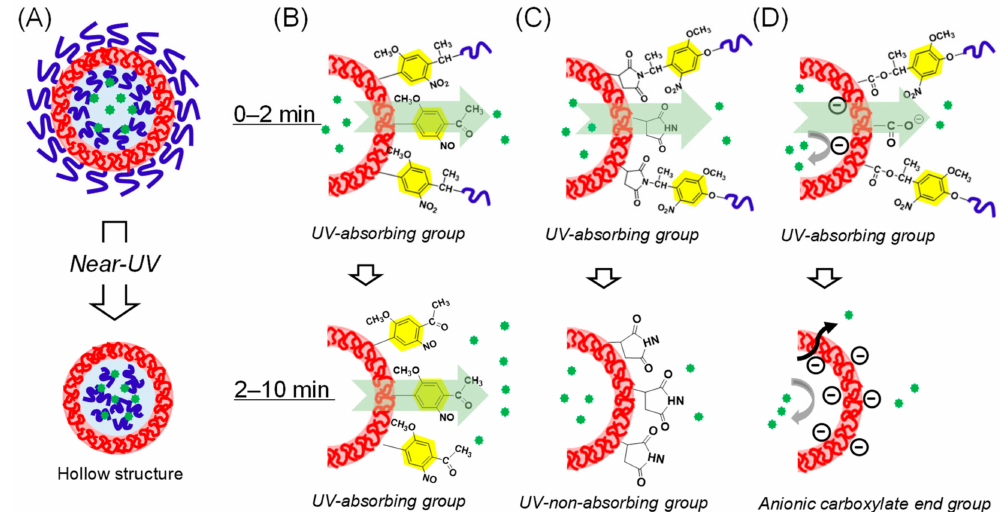
Figure 8. Summary and hypotheses of the photoreleasing mechanism from photoresponsive polymersomes. ( A ) All of the polymersomes retained their hollow structures even after su ffi cient irradiation. ( B–D ) Expected mechanisms of fluorescein photorelease from the polymersomes depending on photolysis residual groups and hydrophobic polymer species during initial 0–2 min (upper images) and subsequent 2–10 min (lower images). ( B ) Polymersomes 1a – c and 2 , with the 2-nitrosoacetophenone end group, which continue absorbing near-UV light and exhibit prolonged light-induced payload release. ( C ) Polymersome 3 , with the non-UV-absorbing succinimide end group, releases only during the UV-absorbing 2-nitrobenzyl group exists. ( D ) Polymersomes 4 and 5 , with the anionic carboxylate end group, exhibit di ff erent photorelease behaviors depending on hydrophobic polymer species; polymersome 4 , with robust crystalline PS hydrophobic shells, shows absolutely no